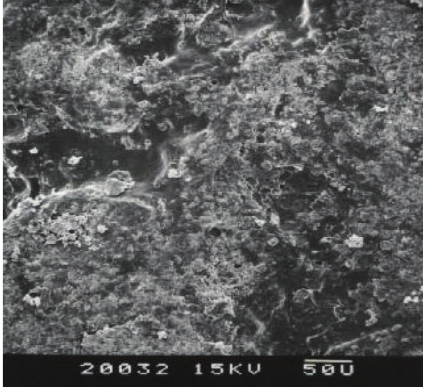
Figure 7: Membrane surface of 10 ∘ C coated fertiliser ( × 200).